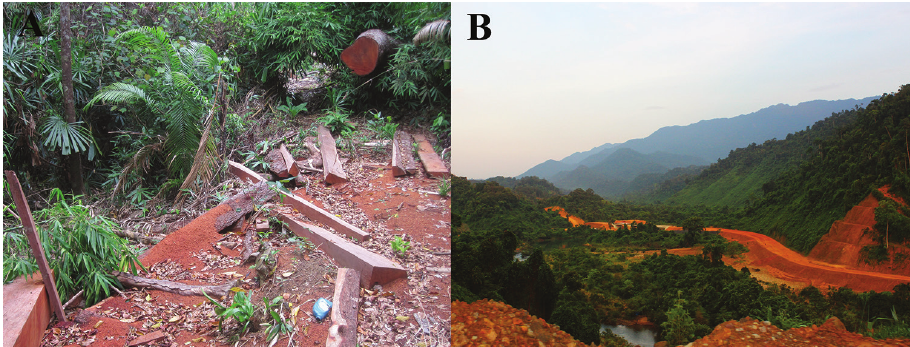
Figure 5. Threats to Physignathus cocincinus in Thua Thien Hue Province: A. Illegal timber logging in Nam Dong District; B. Building a highway from Nam Dong to A Luoi